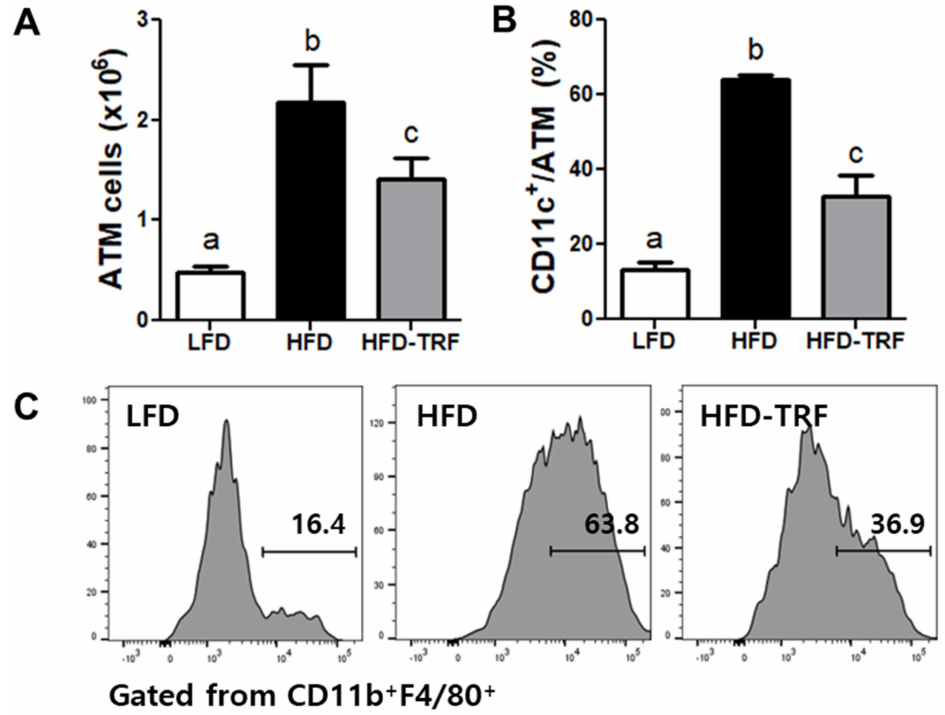
Figure 3. Effects of time-restricted feeding (TRF) on infiltration of adipose tissue macrophages (ATM). Epididymal adipose tissue was analyzed by flow cytometry after 14 weeks of different feeding regimens. LFD, low-fat diet ad libitum; HFD, high-fat diet ad libitum; HFD-TRF, 8 weeks of time- restricted feeding after 6 weeks of high-fat diet ad libitum. ( A ) Total ATM numbers; ( B ) frequency of CD11c + ATM; ( C ) representative flow cytometry histograms of CD11c expression in ATM. Data are presented as mean ± SEM ( n = 7). a,b,c Different superscripts indicate significant difference at least at p < 0.05 by ANOVA with Tukey’s post hoc